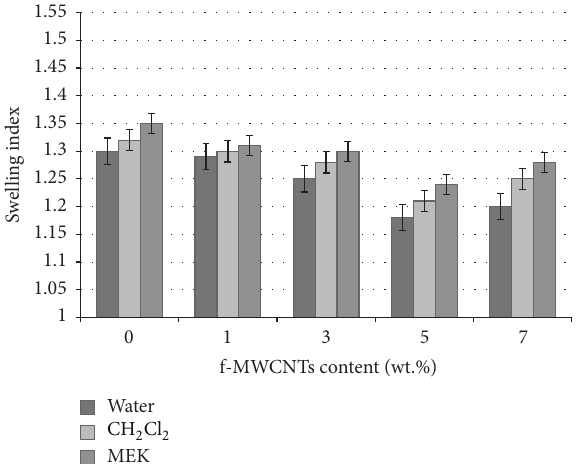
Figure 16: Effect of f-MWCNTs on swelling properties of nanocom-